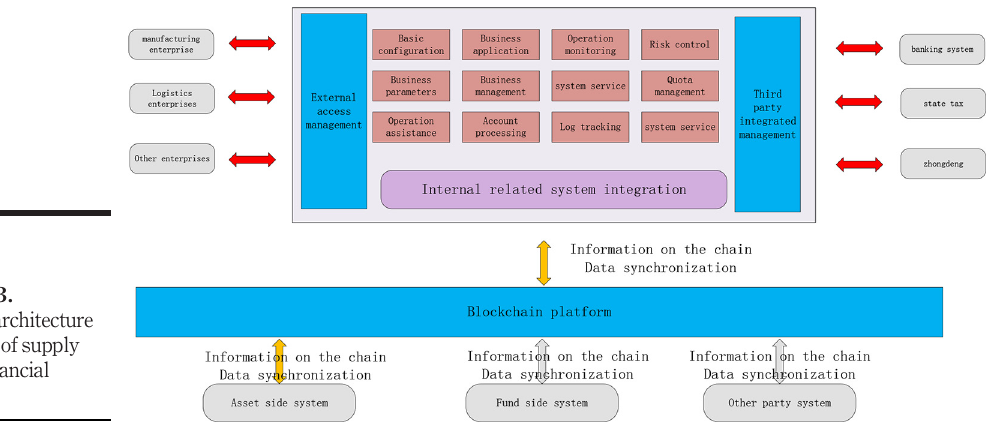
Figure 3. Overall architecture diagram of supply chain fi nancial